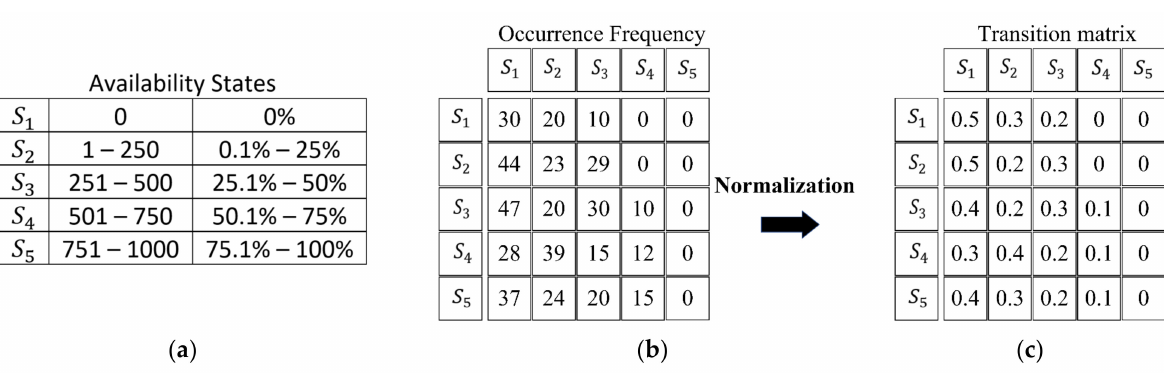
Figure 5. Markov model: ( a ) availability states, ( b ) occurrence frequency, and ( c ) transition